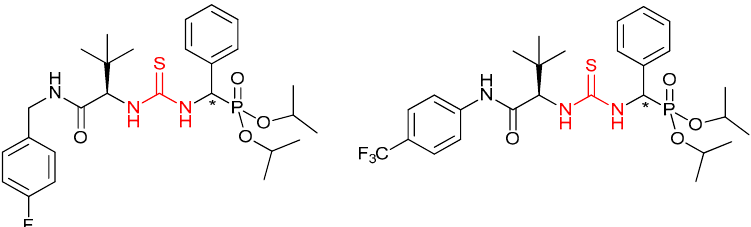
Figure 35. The most active fluorinated thiourea derivatives containing α -aminophosphonate moiety based on leucine [361].